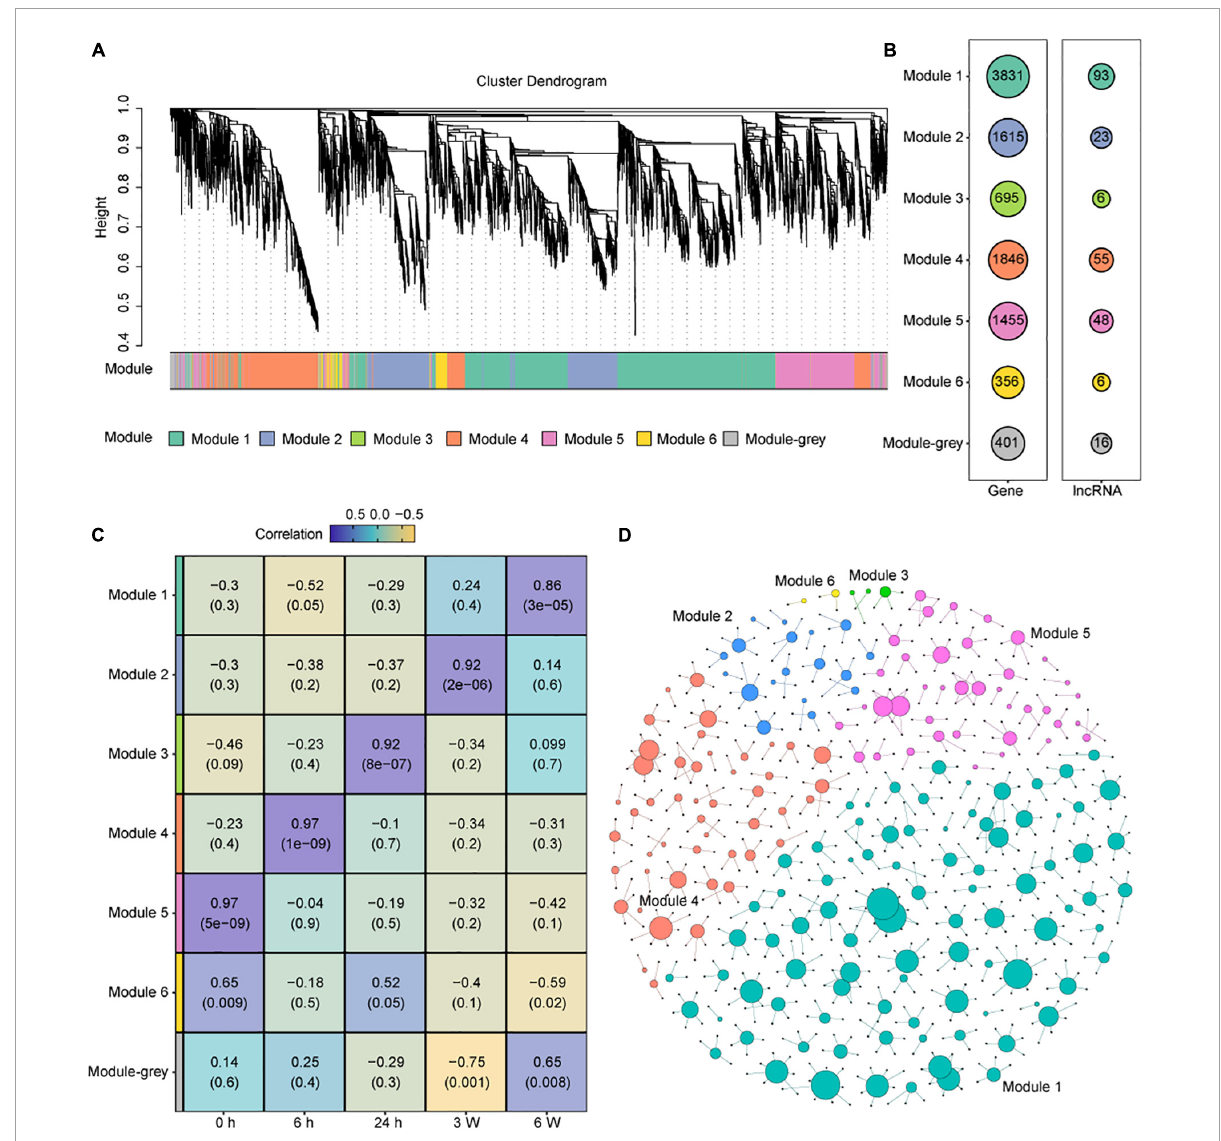
FIGURE5 Construction and identification of the co-expression modules associated with the timepoints, based on the FPKM values of DEG and DAS genes. (A) WGCNA cluster dendrogram showing co-expression modules identified in 15 samples of 5 timepoints. Modules are assigned by distinct colors, respectively. (B) The number of DEGs and DElncRNAs in different Modules. (C) Correlations between modules and cold treatment timepoints. The correlation is estimated by the Pearson correlation coefficient method. (D) Predicted regulatory networks based on DElncRNAs and their potential targeted genes in DEG and DAS genes. Different colors represent different modules and the big dots represent lncRNAs. The detailed information was showing in Supplementary Table 16